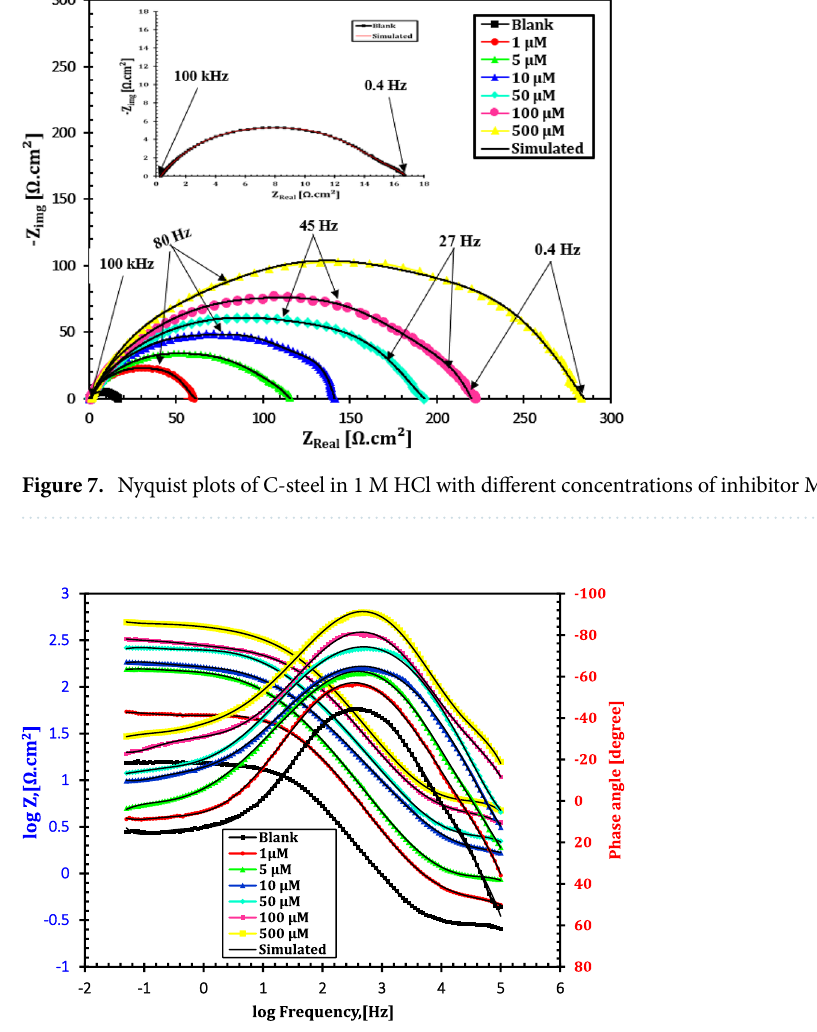
Figure 8. Bode plots of C-steel in 1 M HCl with different concentrations of inhibitor MA-1740 at 25